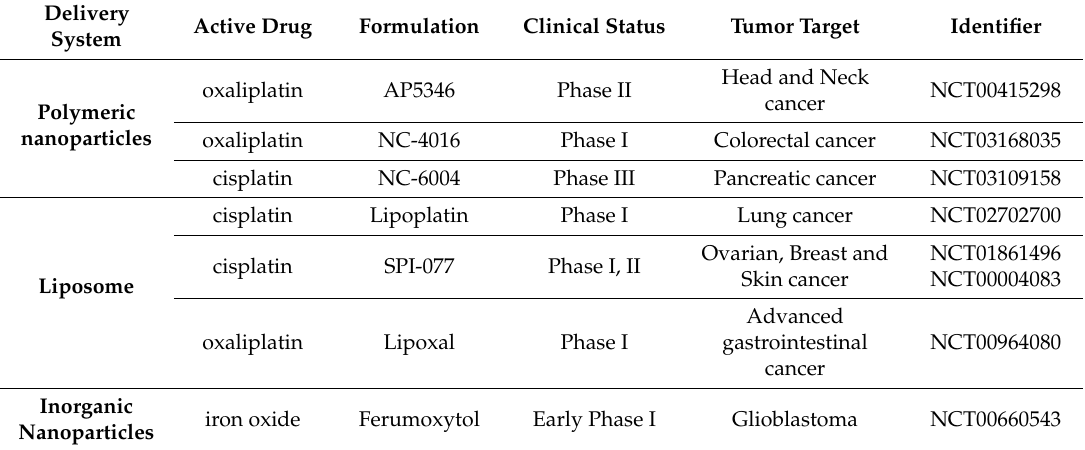
Table 1. Representative metallodrug delivery systems that have entered clinical